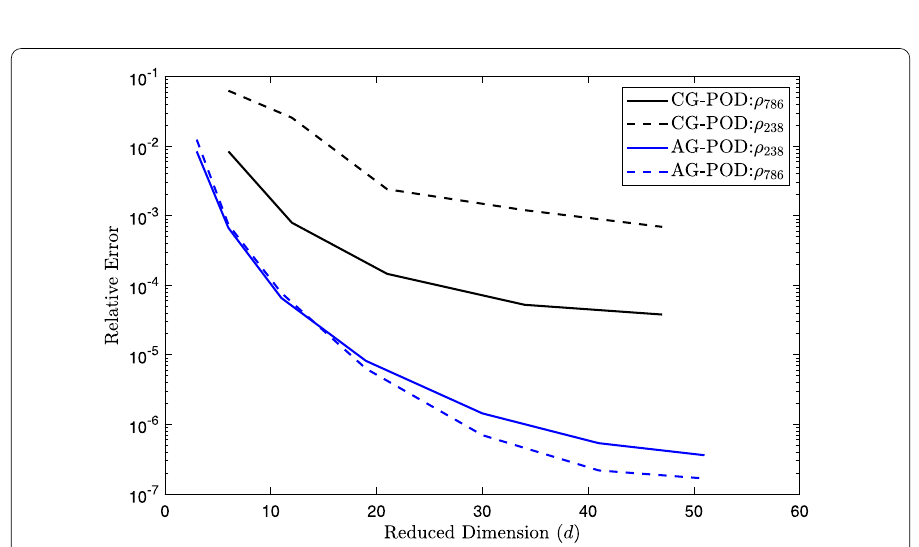
Figure 9 Comparison of classical (CG) and adaptive (AG) greedy sampling